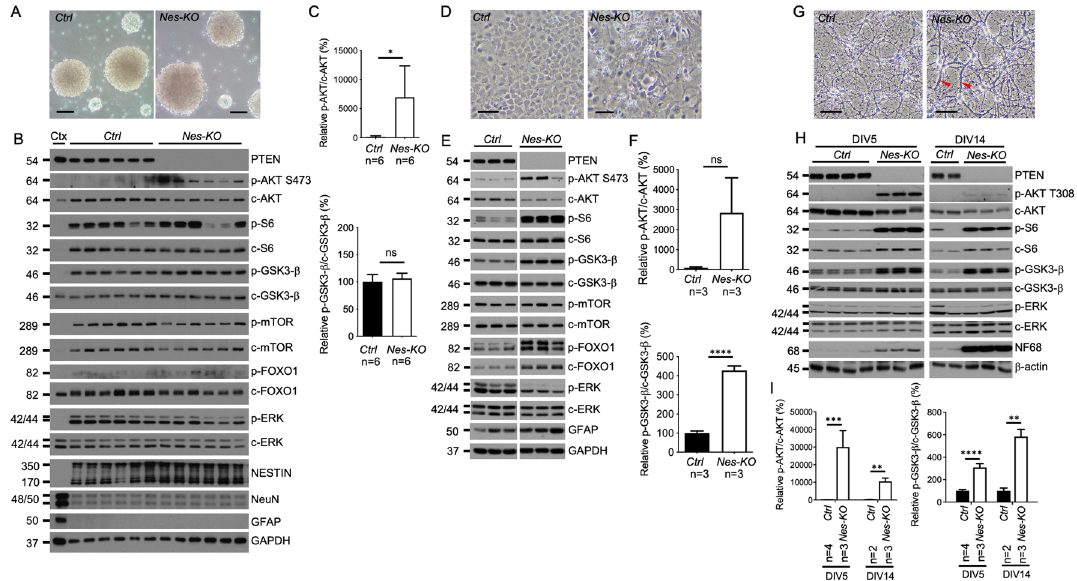
Figure 4. Aberrant PI3-K signalling in Pten -knockout neural cells. Representative bright-field images of primary cultures of ( A ) neural progenitor cells (NPCs), ( D ) astrocytes (ASTs) and ( G ) neurons at DIV14. Scale bar = 0.1 mm. Red arrowheads, hypertrophic neurites. Immunoblotting of the indicated proteins in ( B ) NPCs, ( E ) ASTs and ( H ) neurons of Pten -knockout ( Nes-KO ) and littermate control ( Ctrl ) mice. Cortical lysate from a wild-type mouse (Ctx) was used as a control. The specific phosphorylation of p-AKT and p-GSK3-β relative to control ( Ctrl ) are shown in ( C ) NPCs, ( F ) ASTs and ( I ) PCN. An unpaired Student’s t-test was used for statistical analysis with the indicated p-values: * < 0.05, ** < 0.01, *** < 0.001 and **** < 0.0001.